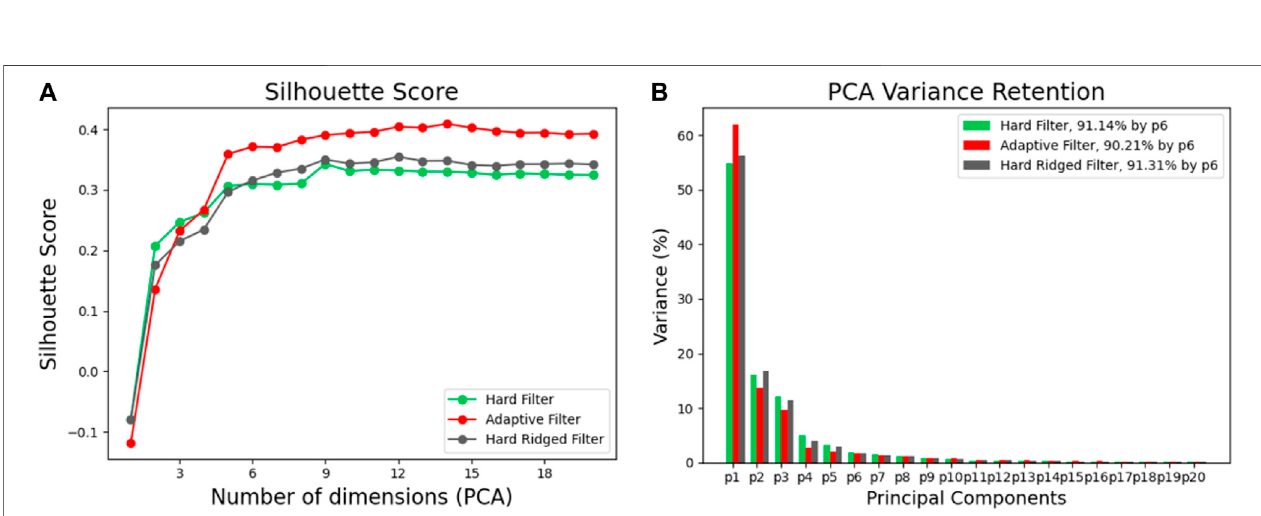
FIGURE 10 | (A) The Silhouette score for the different fi lters for increasing numbers of dimensions. (B) The variance in PCA for the principle components for the three different fi lters.